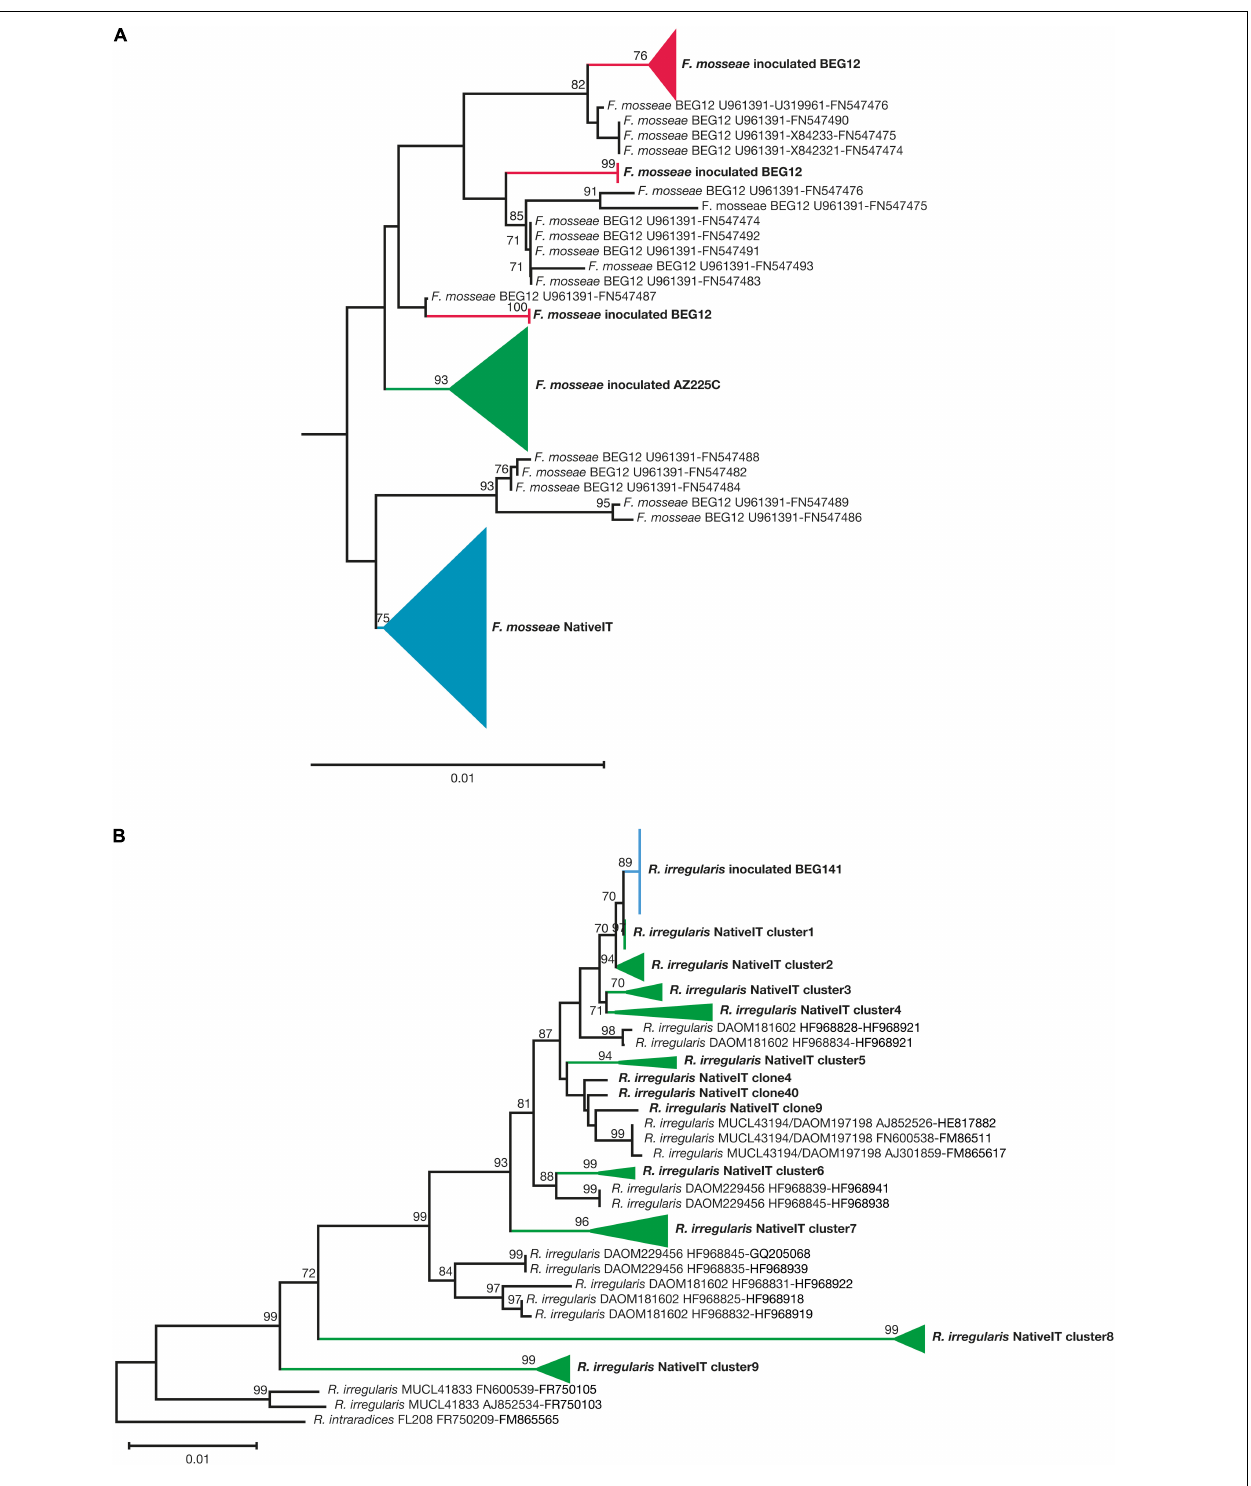
FIGURE 4 | Neighbor-joining (NJ) collapsed tree of the nuclear ribosomal rDNA sequences of F. mosseae, originating from local strains and the non-native inoculated isolates BEG12and AZ225C (A) . The tree is composed of 20 and 24 newly generated sequences of BEG12 and AZ225C, respectively, 39 native F. mosseae sequences, plus 17 sequences of BEG12 as reference. NJ collapsed tree of the nuclear ribosomal rDNA sequences of R. irregularis, originating from local strains and the non-native inoculated isolates BEG141 (B) . The tree is composed of 17 newly generated sequences of BEG141 and 40 native R. irregularis sequences, plus 14 sequences of R. irregularis isolates as reference (DAOM181602, MUCL43194/DAOM197198, DAOM229456, and MUCL41833) The NJ F. mosseae tree is based